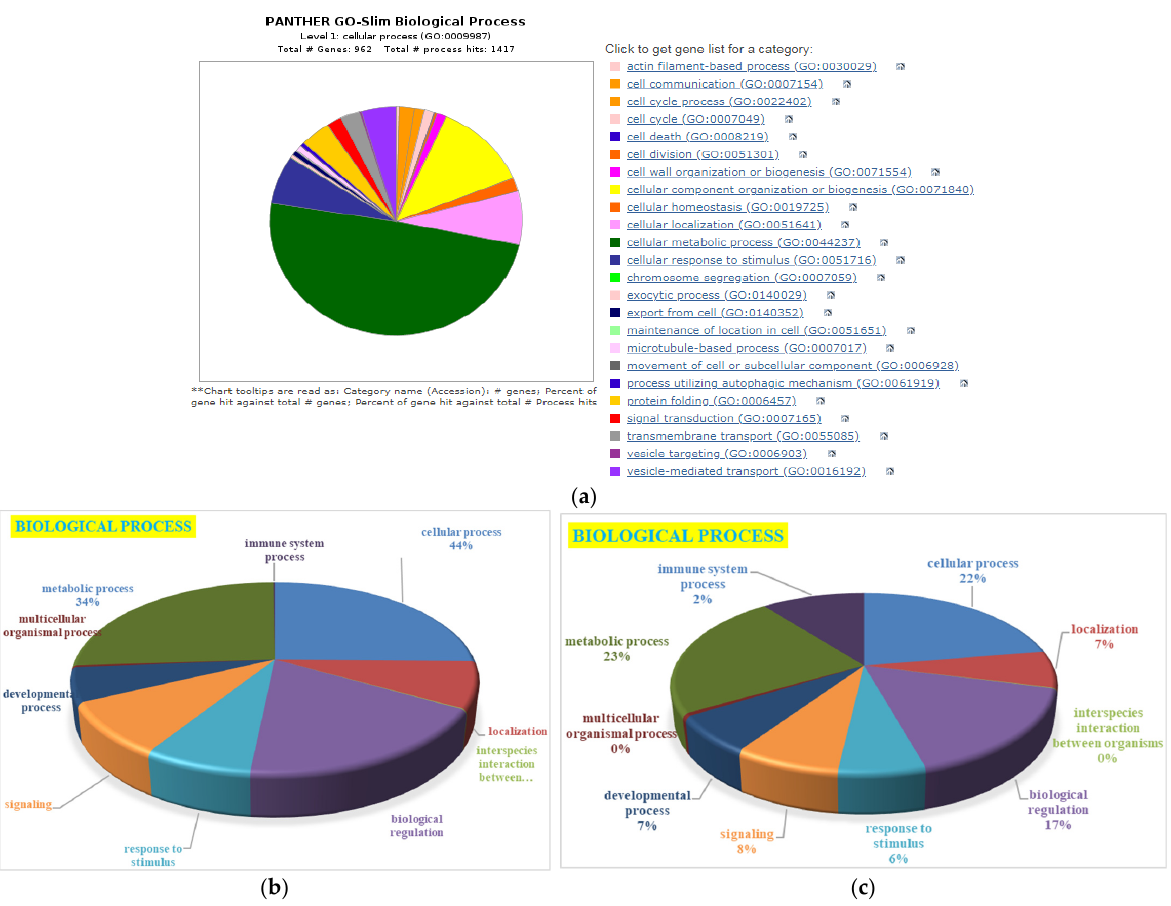
Figure 7. Gene Ontology classification of proteins in HBGH35 and Pusa Naveen ( ♀ ) based on their molecular function.